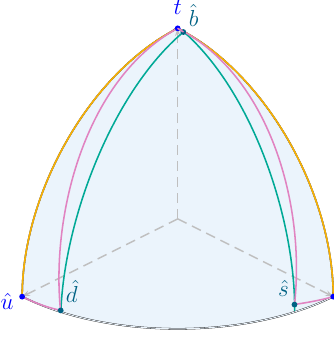
Fig. 3 Trajectories in the space of gBGL models